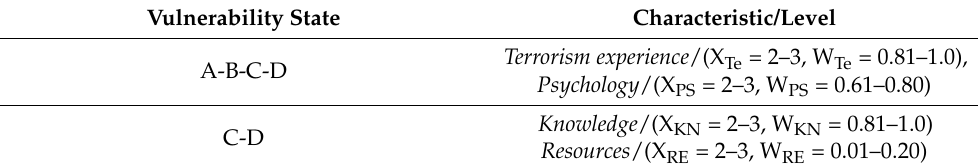
Table 4. Case study attacker characteristics level per vulnerability state.